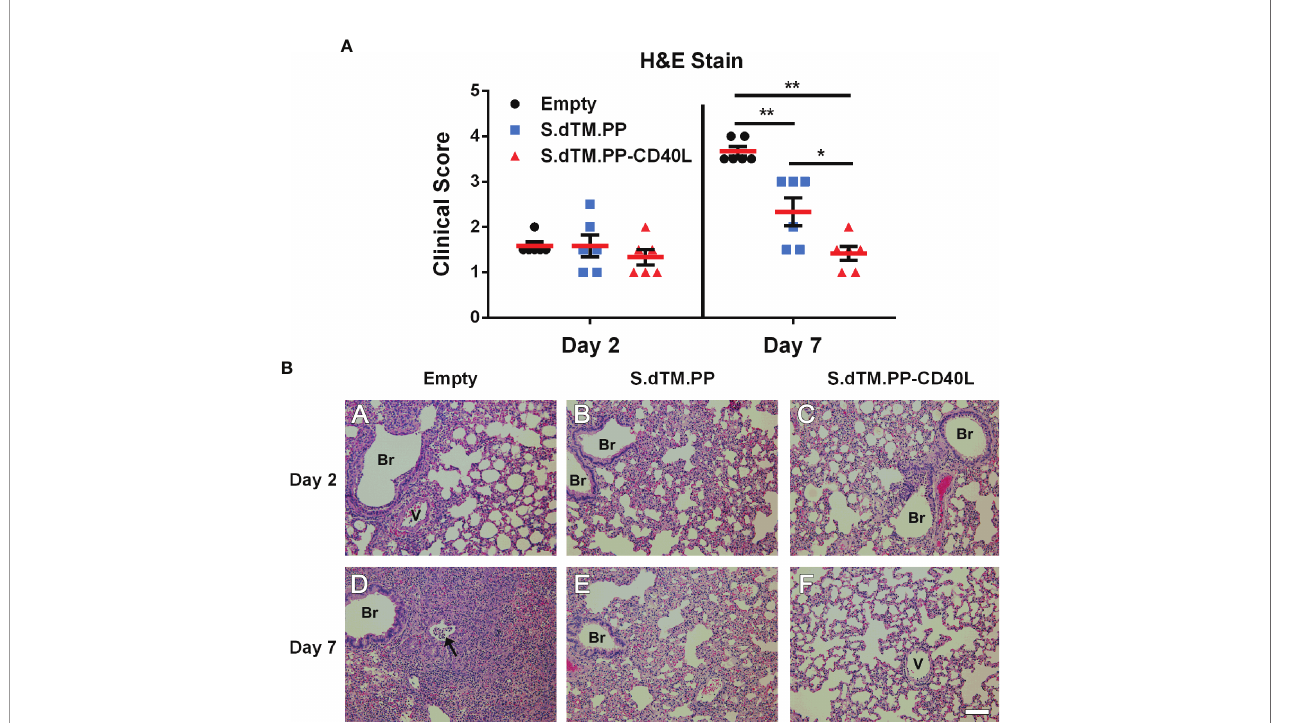
FIGURE 4 | Lung Pathology following SARS-CoV-2 Challenge. (A) Summary of histopathological scores. Data shown is mean± SEM; n = 6 per group. *p < 0.05, **p < 0.01. (B) Representative photomicrographs of lung histopathology in SARS-CoV-2-infected hamsters. Groups of female golden Syrian hamsters (n=6) were intramuscularly immunized with pcDNA3.1 S.dTM.PP, pcDNA3.1 S.dTM.PP-CD40L or empty vector as a control on day 0 and 28. The hamsters were intranasally challenged with 1.0×10 5 PFU of SARS-CoV-2 on day 49 and sacri fi ced 2 or 7 days later. (A-C) Lung histopathology from infected hamsters killed at day 2 post-challenge. The lungs from hamsters vaccinated with empty vector (A), S.dTM.PP (B), and S.dTM.PP-CD40L (C) showed mild to moderate interstitial pneumonia of similar severity. (D-F) Lung histopathology from infected hamsters killed at day 7 post-challenge. (D) The lung from a hamster vaccinated with the empty vector showed areas of consolidation with the occasional presence of mixed in fl ammatory cells in the bronchiolar lumen (arrow). (E) The lung from a hamster vaccinated with S.dTM.PP showed apparent mononuclear in fl ammatory in fi ltration in the alveolar septa and focal areas of consolidation. (F) The lung from a hamster vaccinated with S.dTM.PP-CD40L showed only mild interstitial pneumonia that is milder than that in the hamster vaccinated with S.dTM.PP (E). Br, bronchioles; V, blood vessel. H&E. Bar = 100